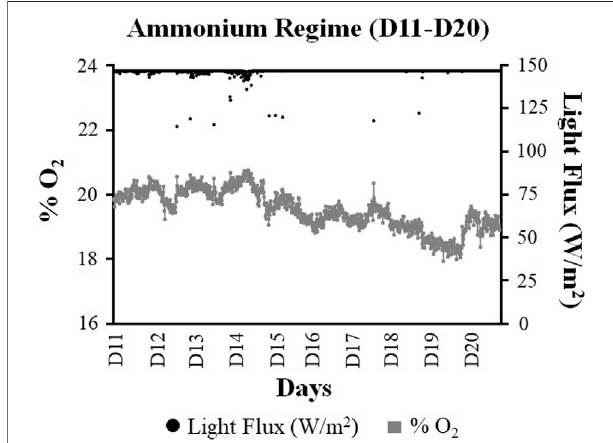
FIGURE 5 | Comparison of the average oxygen (% O 2 ) and light fl ux (W/m 2 ) values quanti fi ed using the monitoring system during the ammonium regime of the ground demonstration (Day 11 – Day 20). For the graphical representation of data, the values have been reported as the 15-min average of each analyte.